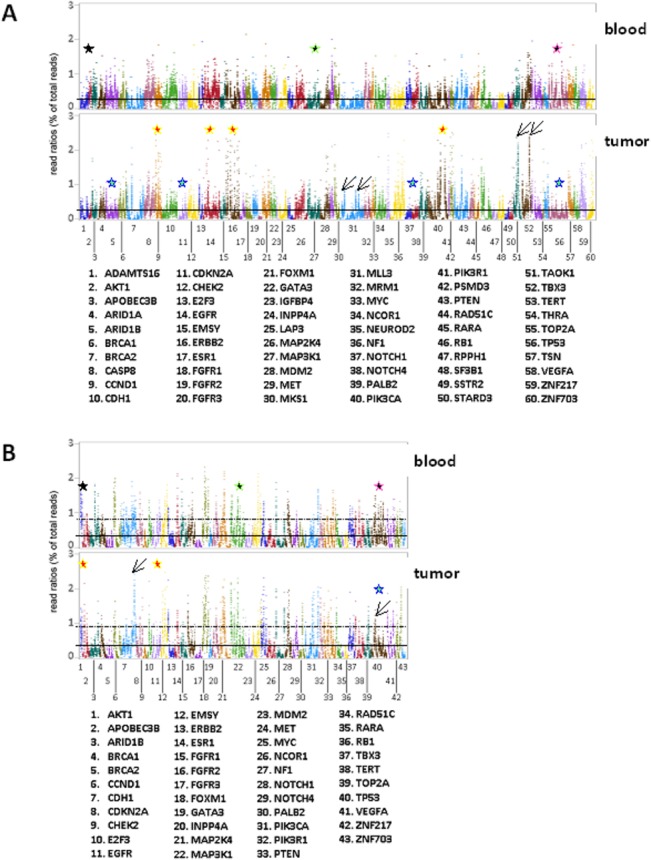
Performance of the B and T panels in DNA from matched blood and tumor FFPE samples.
A: B panel; B: T panel. Read ratios for all amplicons for matched samples sorted per gene are shown, corresponding to 70192 observations with the B and 26128 observations with the T panel. Lanes and dots therein represent mean read ratios per amplicon for all samples tested in the respective group. Amplicon order is the same in all graphs. Solid and dotted horizontal lines within graphs: mean values + 3xSD per panel per sample type, respectively. Amplicon reading efficiency was overall constant between blood—FFPE samples with the same panel. For some genes with frequent gains in breast cancer, e.g., CCND1, EGFR, ERBB2, PIK3CA (B panel) and AKT1, EGFR (T panel) outliers with maximal amplicon read ratios outside the Y-axis were observed (A & B, red stars in tumor graphs). By contrast, for genes frequently lost in breast cancer, e.g., TP53 with both panels, mean read ratios in tumor DNA were lower than in blood (A & B, turquoise stars). FFPE-specific over-representation of individual amplicons was occasionally observed (A & B, diagonal arrows). Importantly, patterns of read ratios occasionally differed for genes targeted with the same amplicons in panels B and T, e.g., for ARID1B, MAP3K1, TP53 (A & B, black stars with coloured outlines in blood graphs).